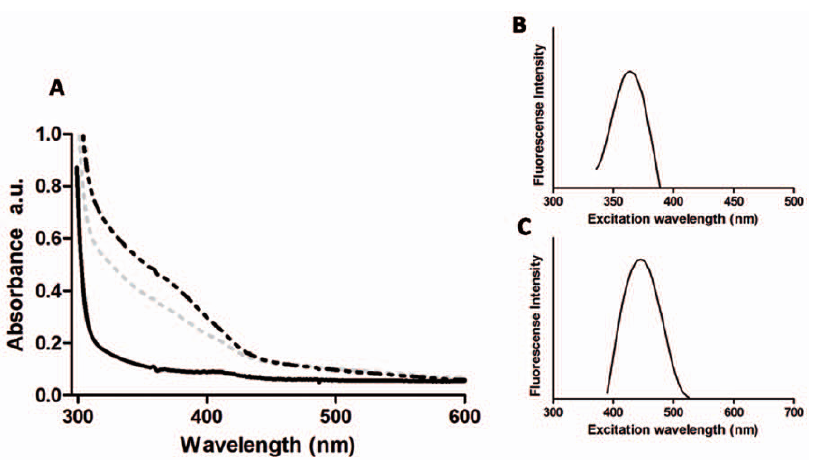
Figure 5. Absorbance and fluorescence spectra of purified NPs. A , absorption spectra of NPs from unexposed (solid black line), exposed to CdCl 2 (dashed grey line) or CdCl 2 /K 2 TeO 3 (dashed black line) cells. B and C , emission spectra of NPs from cells exposed to CdCl 2 or CdCl 2 /K 2 TeO 3, respectively.